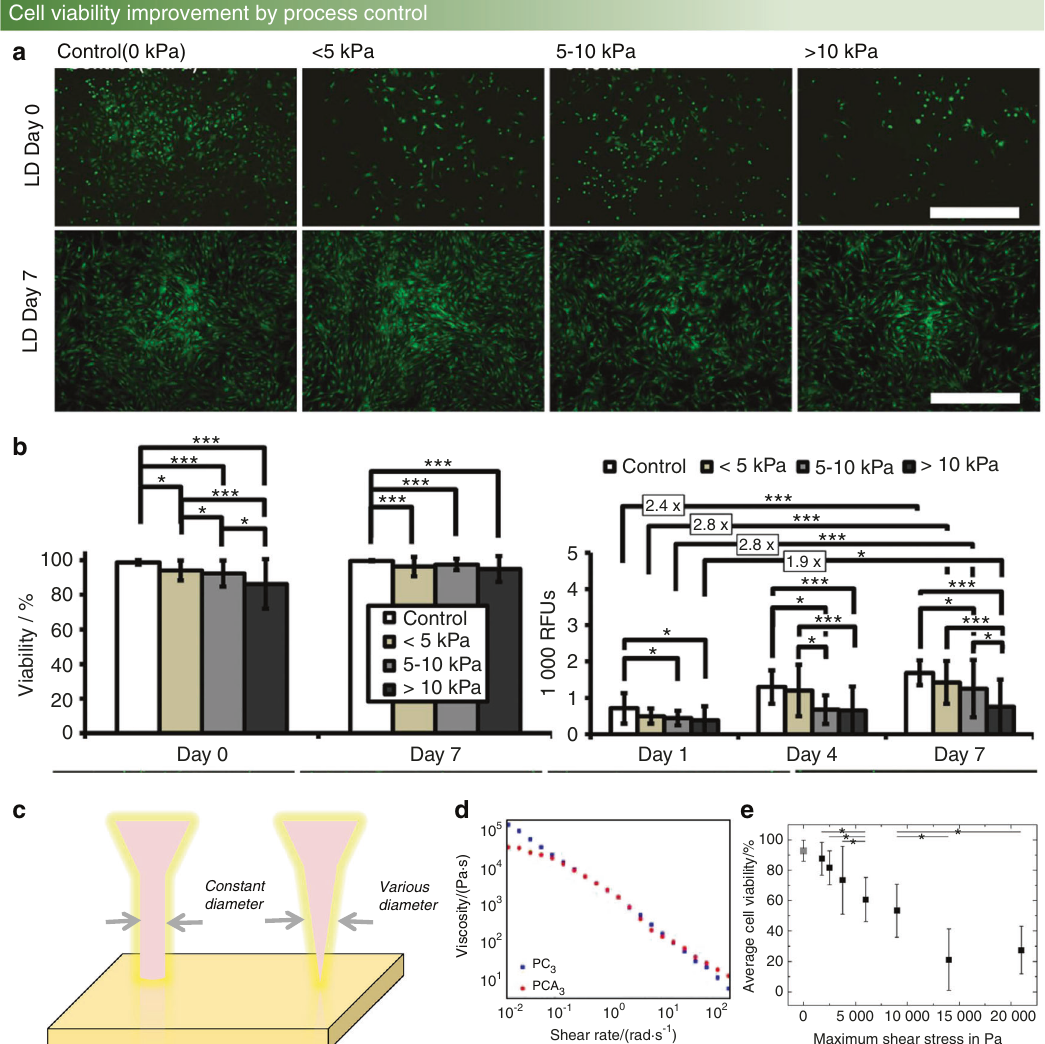
Fig. 6 Cell viability in different fabrication environments. a , b Short-term and long-term impact of different bioprinting-induced shear stress levels on human mesenchymal stem cell (MSC) viability and proliferation. 93 c Cylinder-shaped nozzle head (left) and conical-shaped nozzle head (right). d Shear-thinning tests of PCL-PEG-PCL (blue, square) and PCLA-PEG-PCLA (red, circle). 101 e Viability of immortalized mesenchymal stem cells after extrusion-based bioprinting at a concentration of 0.5×10 6 cells per mL in an alginate-gelatin hydrogel. Maximum shear stress values between 1 747 Pa and 21 000 Pa were generated during printing. 103 (Figures adapted with permission from Blaeser et al., 93 Cui et al., 101 and Koch et al. 103